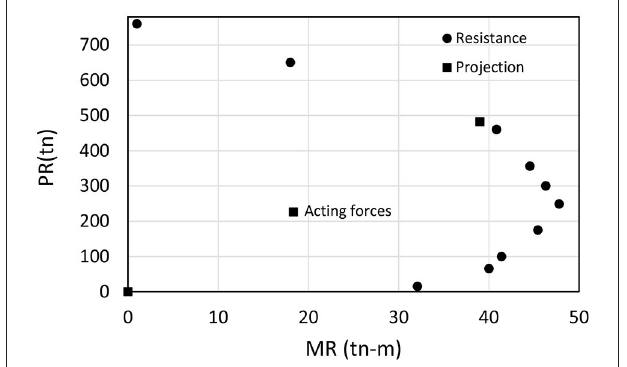
where r = net annual interest rate, and T = structure